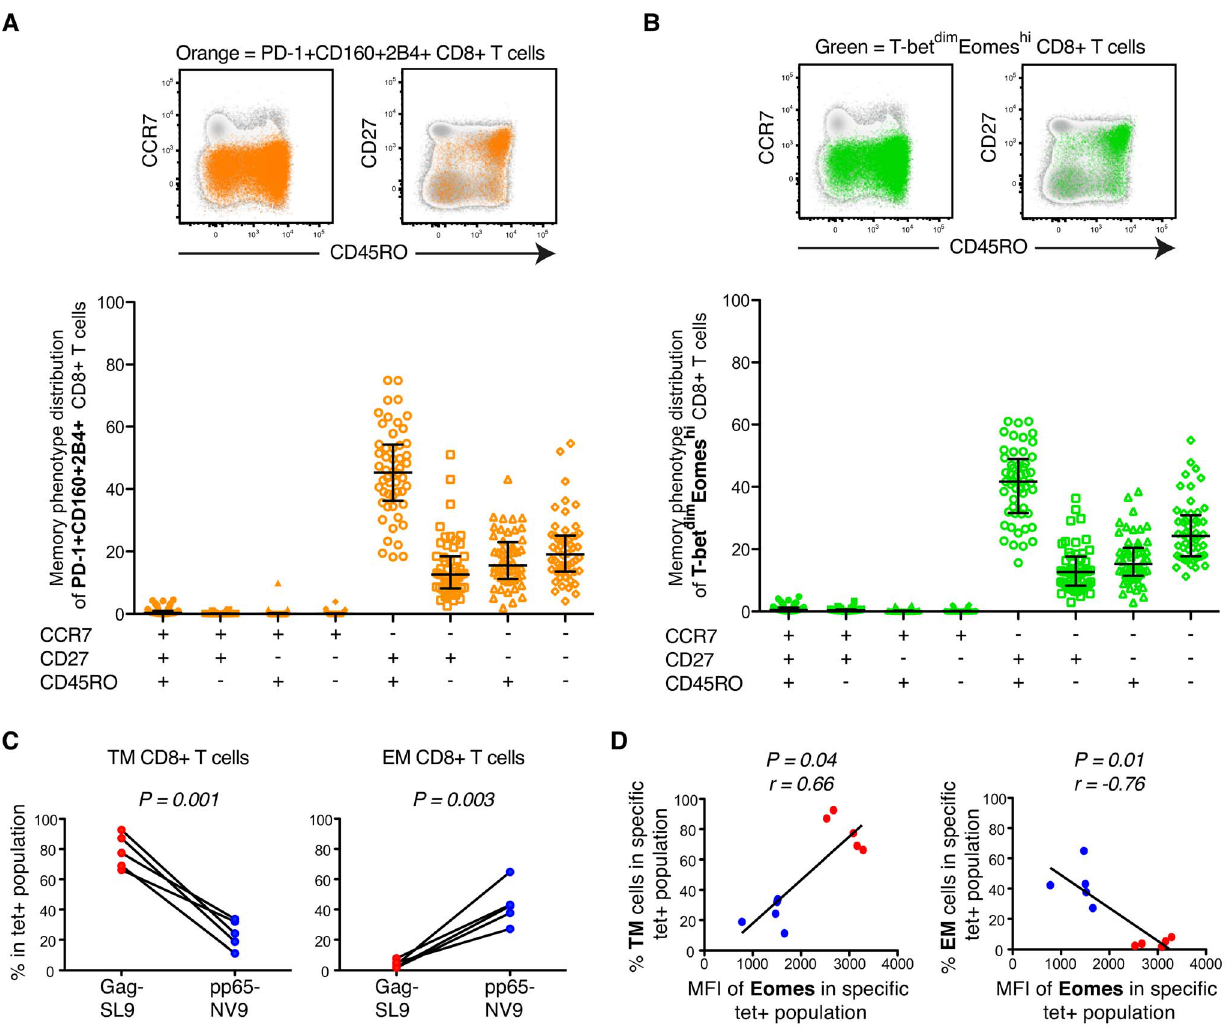
Figure 5. Phenotypic characterization of T-bet and Eomes expression in untreated HIV-infection. (A) Representative plots of an untreated HIV infected patient showing the distribution of total PD-1 + CD160 + 2B4 + CD8 + T cells (orange) within different memory phenotype compartments, based on CD45RO, CD27 and CCR7 expression. The distribution of total PD-1 + CD160 + 2B4 + CD8 + T cells was determined in all chronic untreated HIV infected subjects (B) FACS plots from an HIV infected subject showing the distribution of total T-bet dim Eomes hi (green) cells within the different memory phenotype compartments. Also, the phenotypic distribution of total T-bet dim Eomes hi CD8 + T cells within different memory compartments for all untreated HIV infected subjects. Median and IQR are shown for all populations. (C) The % of TM and EM compartmentalization for Gag/SL9-tet + and pp65/NV9-tet + cells. Paired t-tests were used to compare differences between the groups. (D) Correlations between the MFI of Eomes and TM or EM compartmentalization of Gag/SL9-tet + and pp65/NV9-tet + cells. Spearman non-parametric test was used to test for